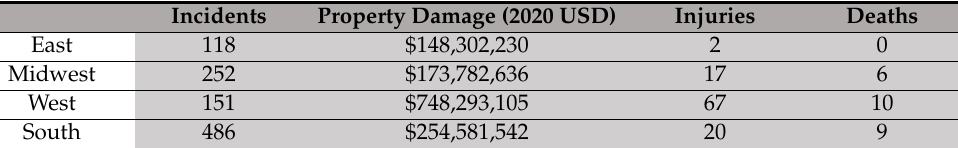
Table 2. Incidents and damage by region,